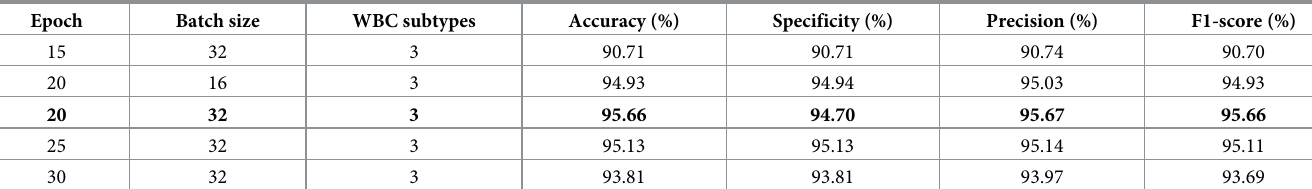
Table 3. Training results of tri-classification of BCCD images under different epoch and batch size.